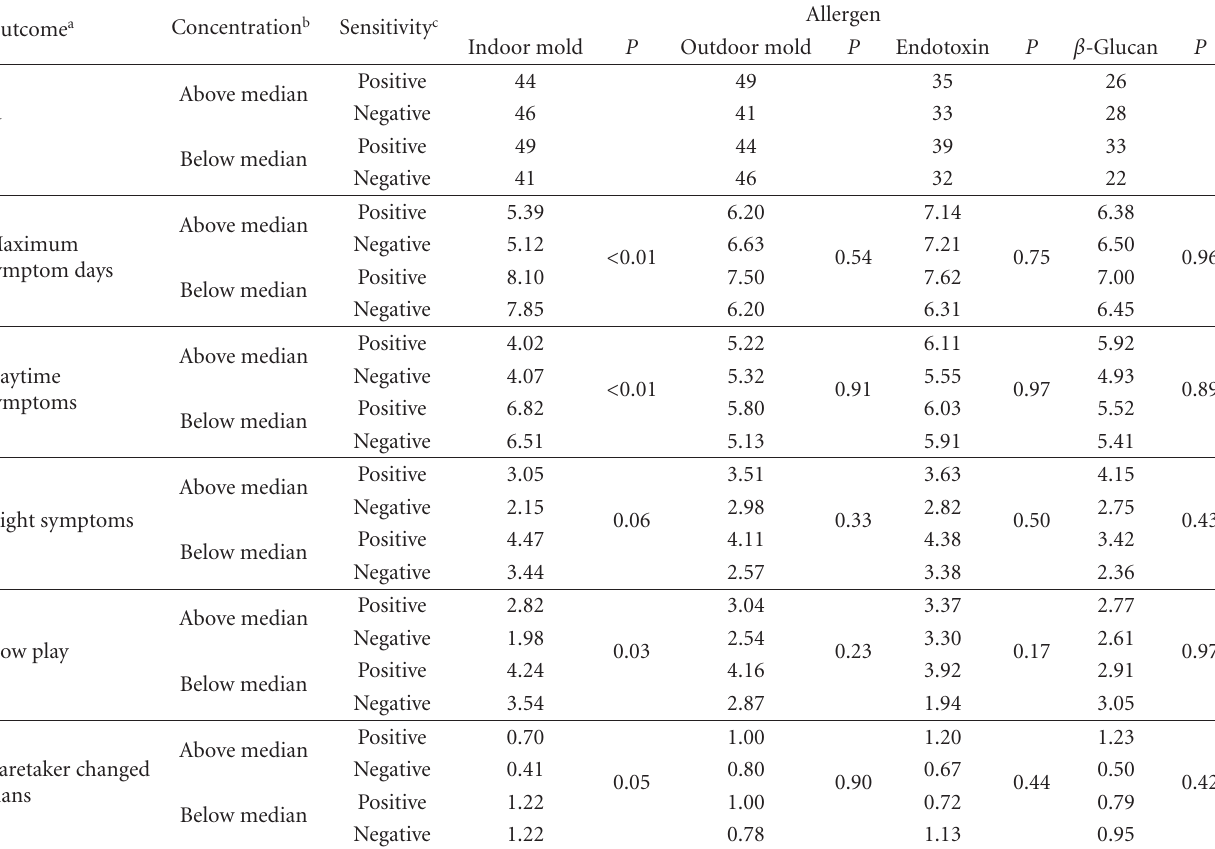
Table 4: Relationship among asthma morbidity, mold sensitivity and airborne mold, endotoxin, or glucan concentrations. Outcome a Concentration b